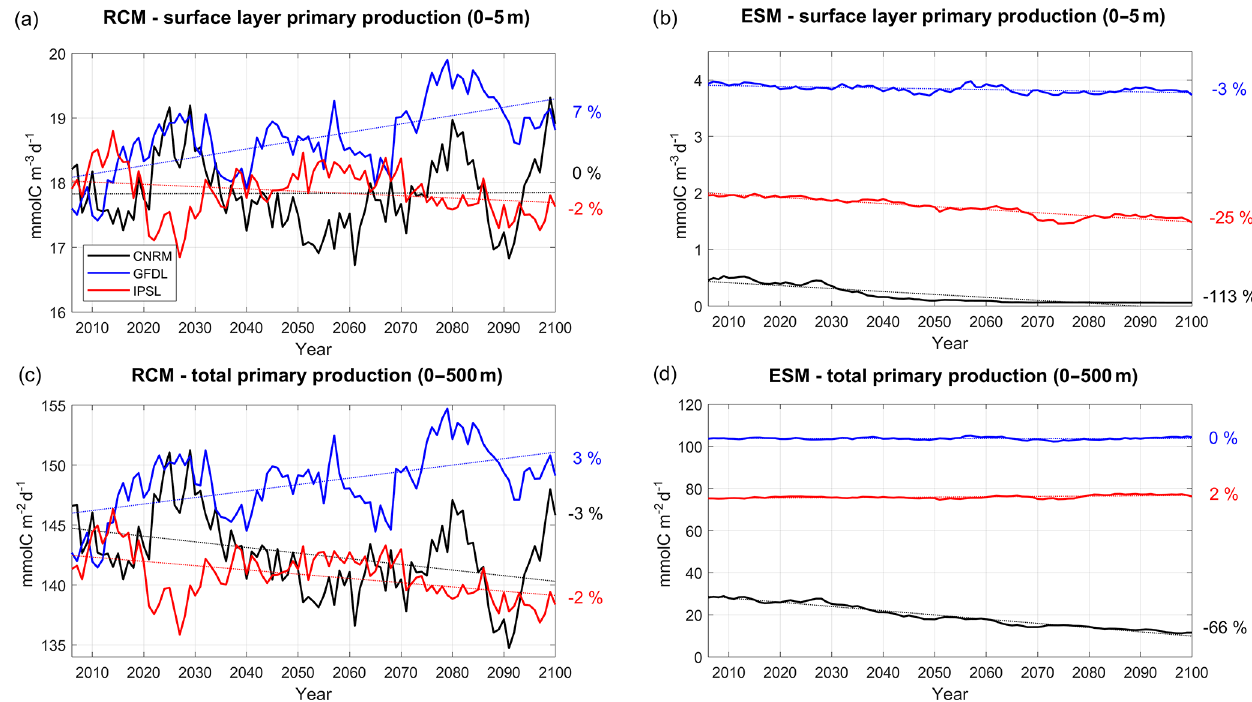
Figure 14. Same as 12 but for primary production (mmolCm − 3 d − 1 ) for the 0–5m surface layer in (a) and (b) and for the depth-integrated values (mmolCm − 2 d − 1 ) in (c) and (d)